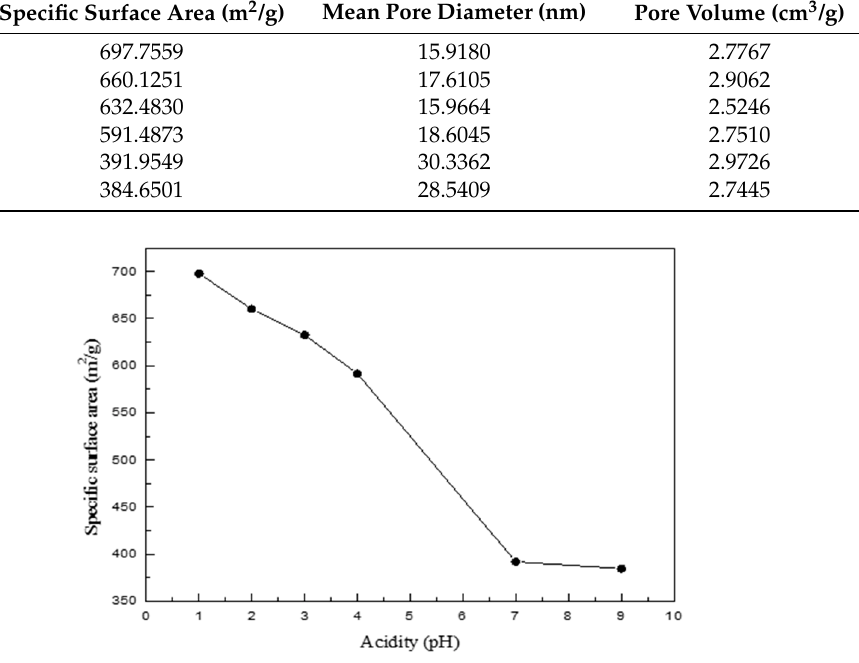
Figure 3. Variation in the specific surface area of the synthesized silica aerogels depending on the pH